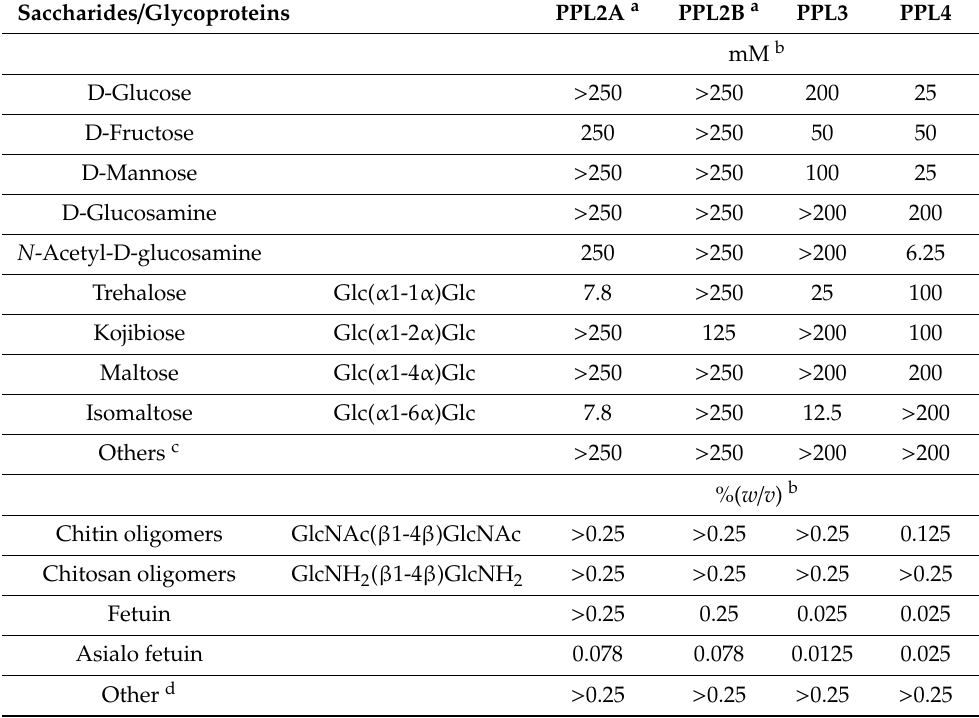
Table 1. Carbohydrate-binding specificities of PPL3s and PPL4 compared with PPL2A and 2B. Saccharides /